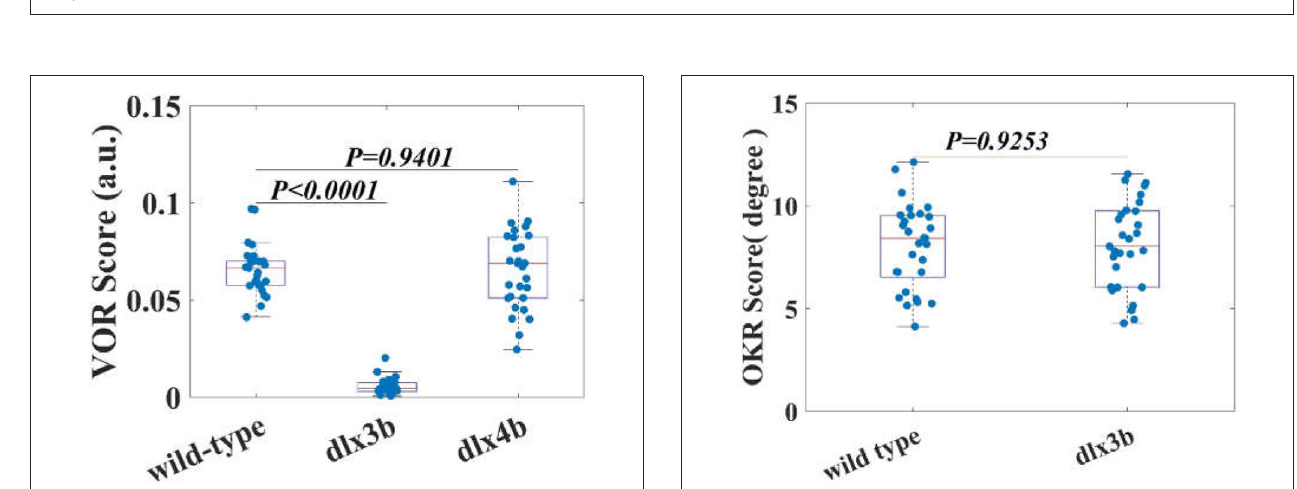
FIGURE 3 | By calculating the projected area of the eyes in a video series in the frontal plane of a larva, the eye movements with time are plotted, as shown in (A) . The eye movements in the time domain are then transferred into the spectral domain (B) using FFT, and the peaks at stimulus frequency is used to quantify the amplitude of eye movements and VOR.